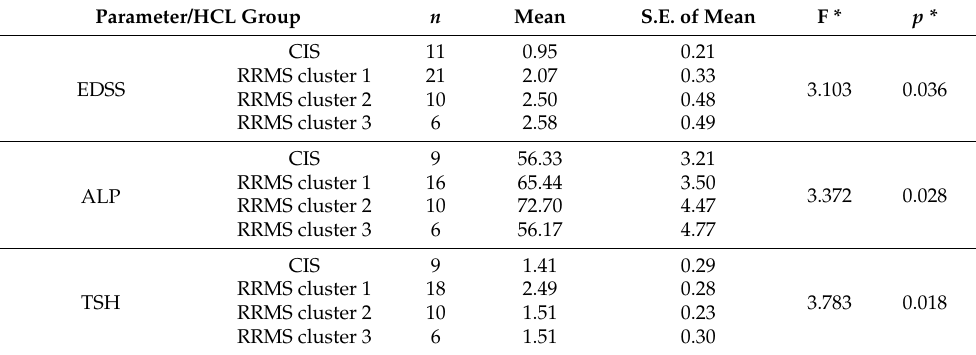
Table 3. Clinical, radiological and laboratory parameters for patients with Clinically Isolated Syn- drome and for patients with Relapsing-Remitting Multiple Sclerosis stratified into three clusters (1–3) derived from Hierarchical Cluster Analysis on the basis of serum metabolomic